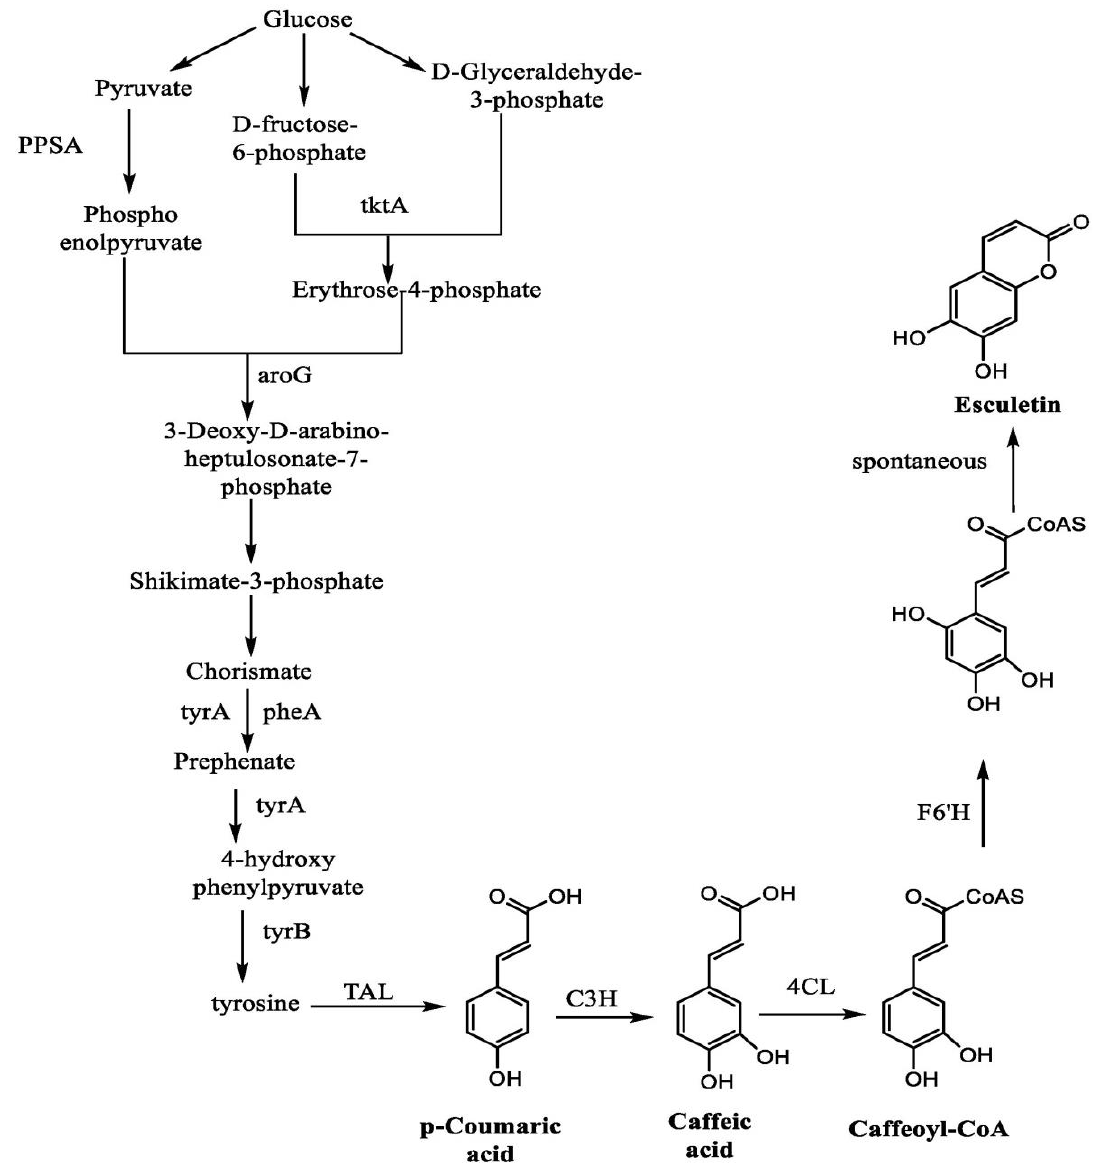
Figure 11. Synthesis of esculetin from glucose .